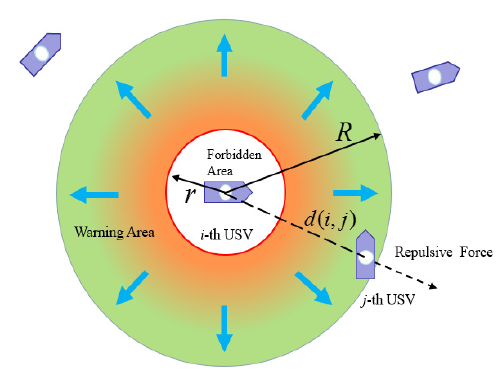
Figure 3. Inter-USV collision